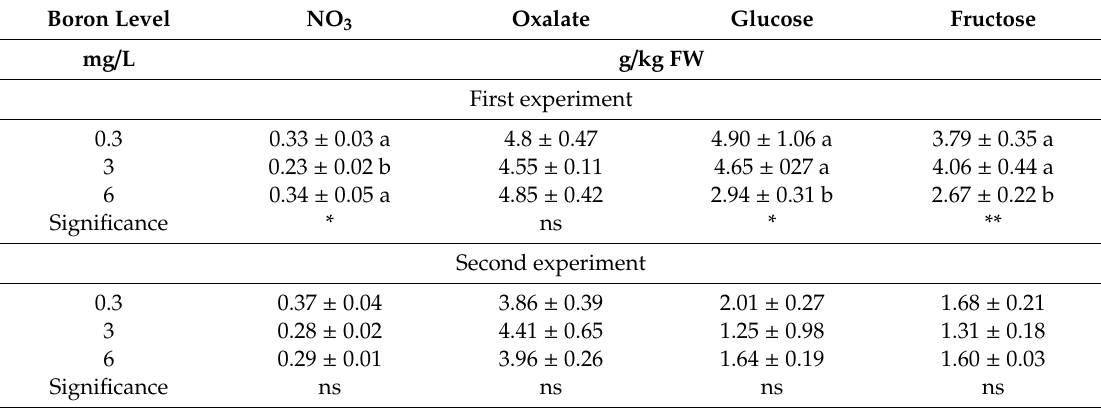
Table 3. E ff ects of di ff erent boron levels in the nutrient solution on the content of nitrate, oxalate, glucose, and fructose in edible parts of wild (first experiment) and commercial (second experiment) purslane. Boron Level NO 3